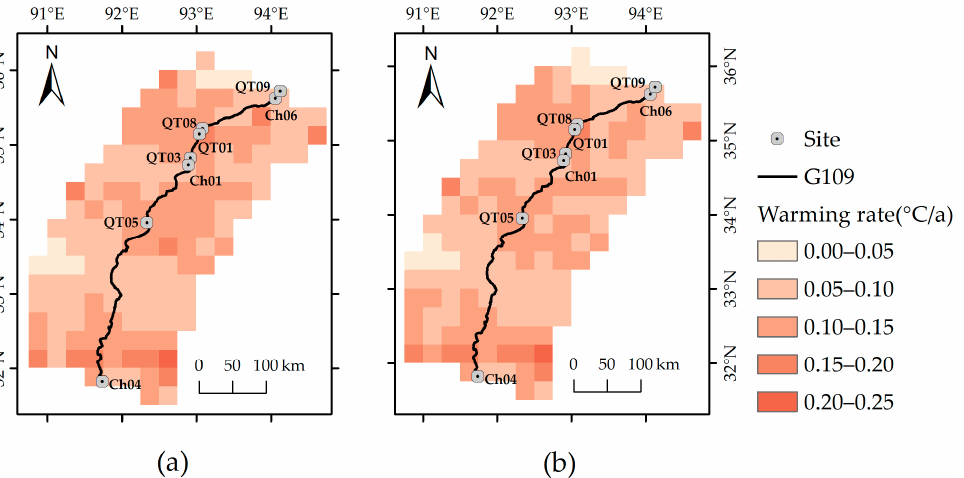
Figure 7. Annual variation in soil temperature of 10 cm ( a ), 50 cm ( b ).